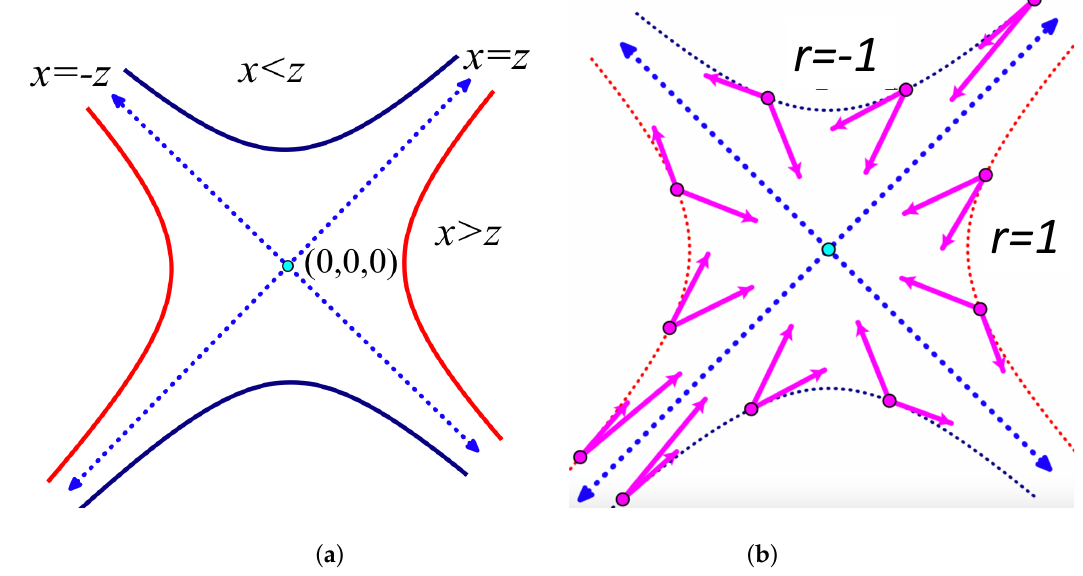
Figure 10. A section of Minkowski 3-space M 3